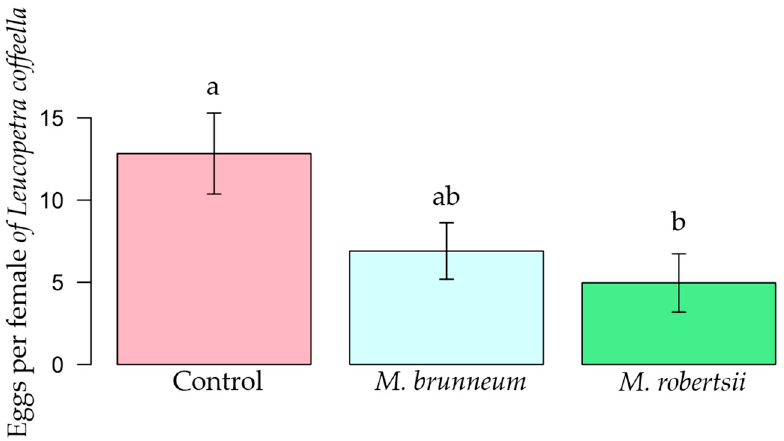
Figure 7. Number of eggs per female of Leucoptera coffeella emerged in coffee seedlings with Metarhizium robertsii and Metarhizium brunneum inoculation by soil drench Inoculation of 30 mL of each isolate suspension was to the surface of the soil in each coffee seedling while the control received a sterile solution of Tween 0.05%. Bars with the same letters are not statistically